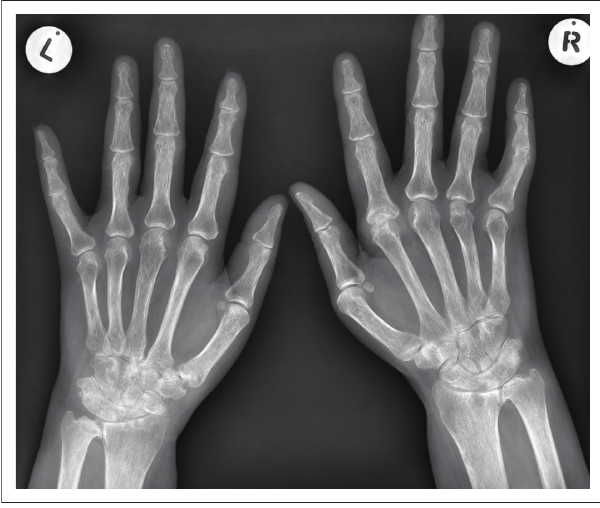
FIGURE 1: Fontal radiograph of both hands demonstrating bilateral symmetrical disease.